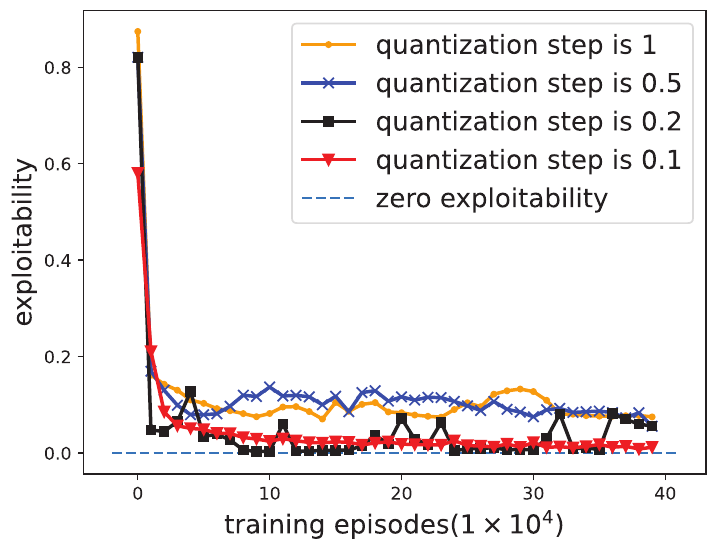
Figure 9. Exploitability curves of different quantization